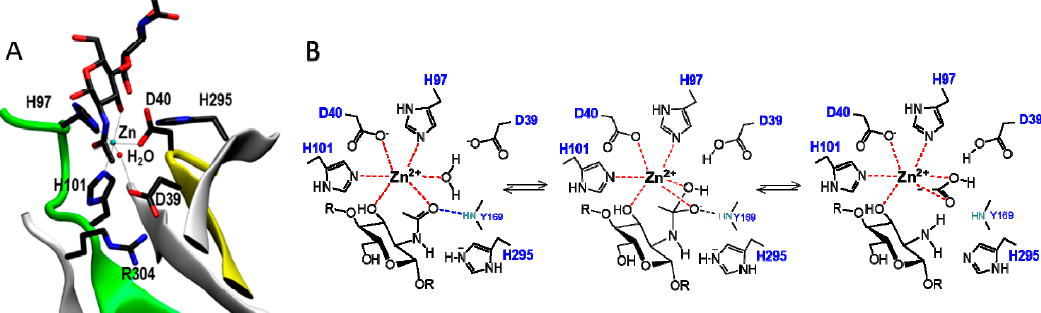
Figure 6. ( A ) Active site residues in the X-ray structure of the Vc CDA·DP2 complex, showing Zn 2+ coordination and substrate binding; ( B ) Metal-assisted general acid/base mechanism proposed for CE4 deacetylases. Scheme based on the 3D structure of the enzyme–substrate complex Vc CDA D39S ·DP2 [62]. D39 is the general base and His295 is the general acid.